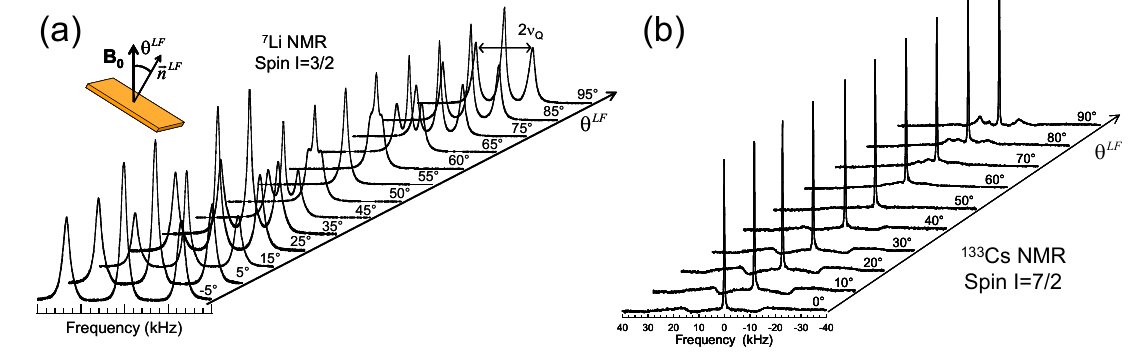
Figure 5. NMR spectra recorded as a function of the film orientation θ LF of the clay sediment into the static magnetic field B 0 : ( a ) 7 Li NMR spectra measured within laponite concentrated clay dispersions; ( b ) 133 Cs NMR spectra measured within hectorite clay sediment. Reprinted with permission from [55]. Copyright (2015) American Chemical